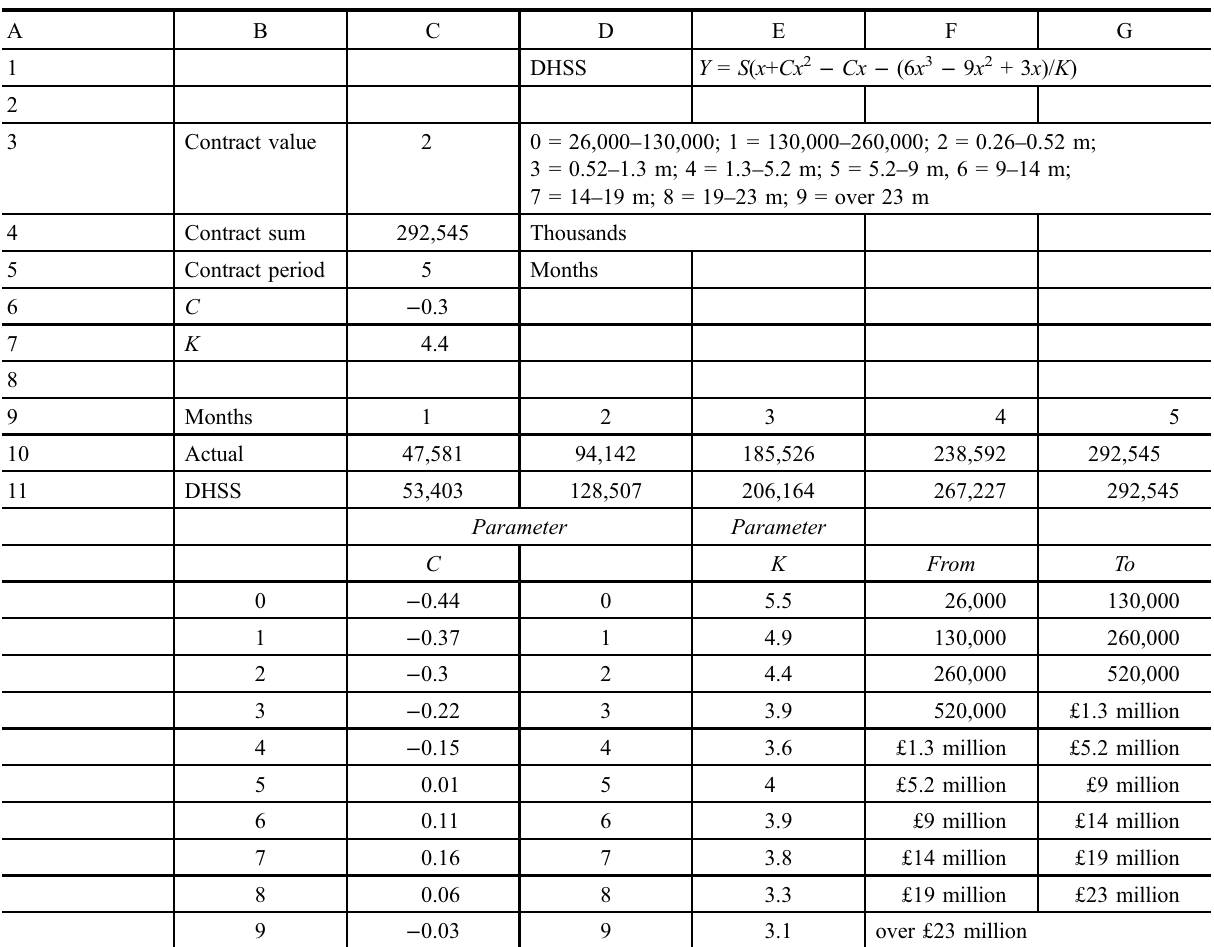
Table 3. Application of Hudson ’ s DHSS